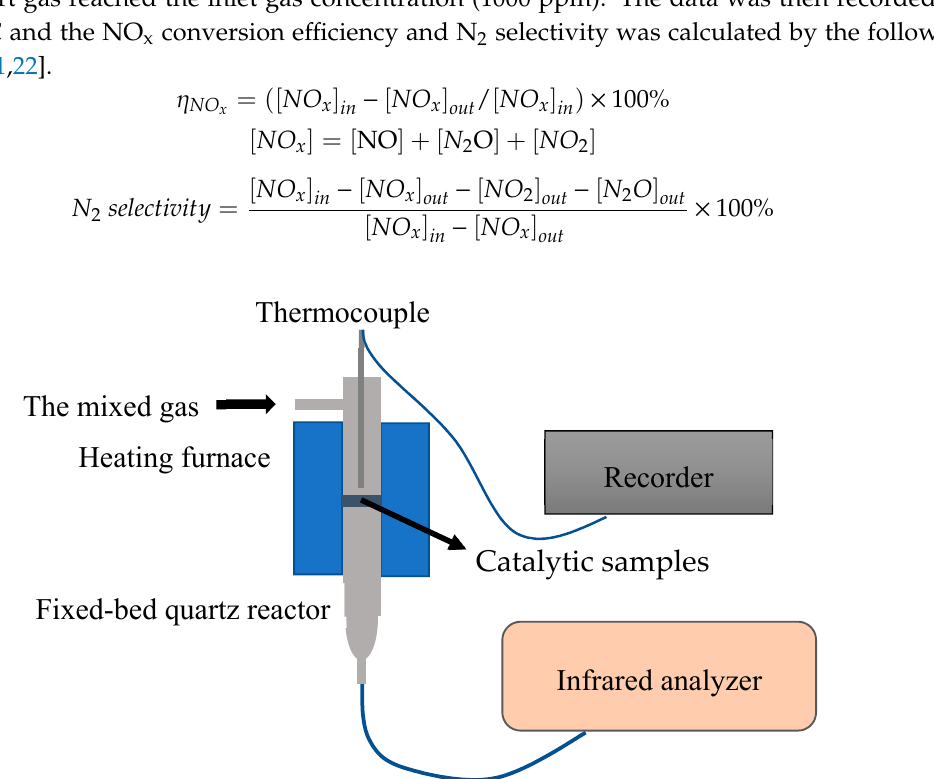
Figure 3. Schematic diagram of the selective catalytic reduction (SCR) testing